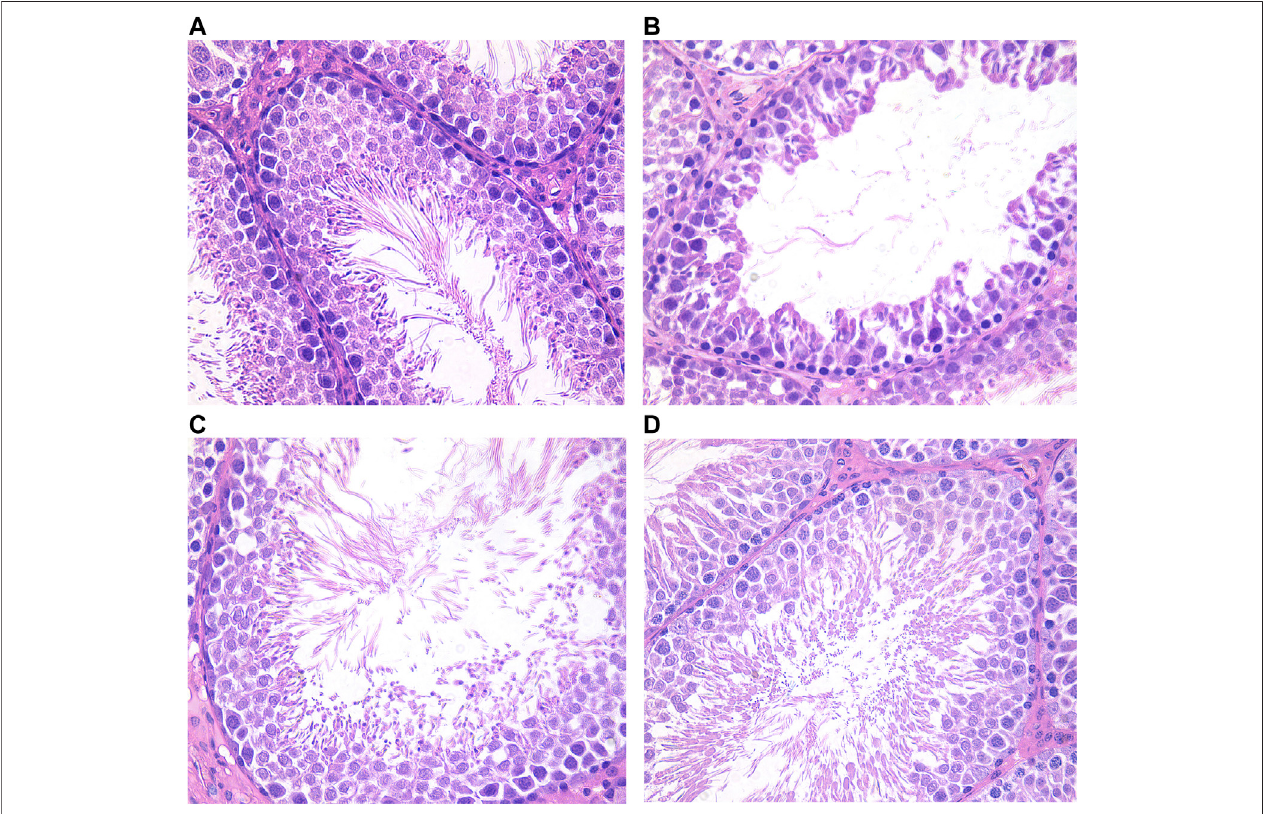
FIGURE 6 | Testis histological changes of male rats in each group (HE × 400). (A) Blank group; (B) Model group; (C) ULRA group; (D) YF group. HE, hematoxylin- eosin staining; ULRA, unprocessed lateral root of Aconitum carmichaelii ; YF, Yinfupian.